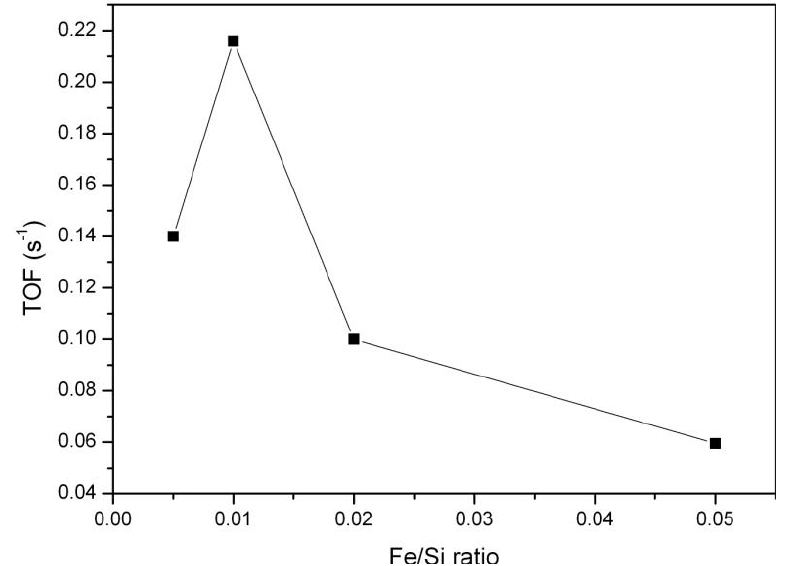
Figure 7. Dependence of catalytic activity (on stream toluene oxidation after 60 min at a constant temperature of 380 °C) upon the iron concentration for the FeKIL-2 samples.